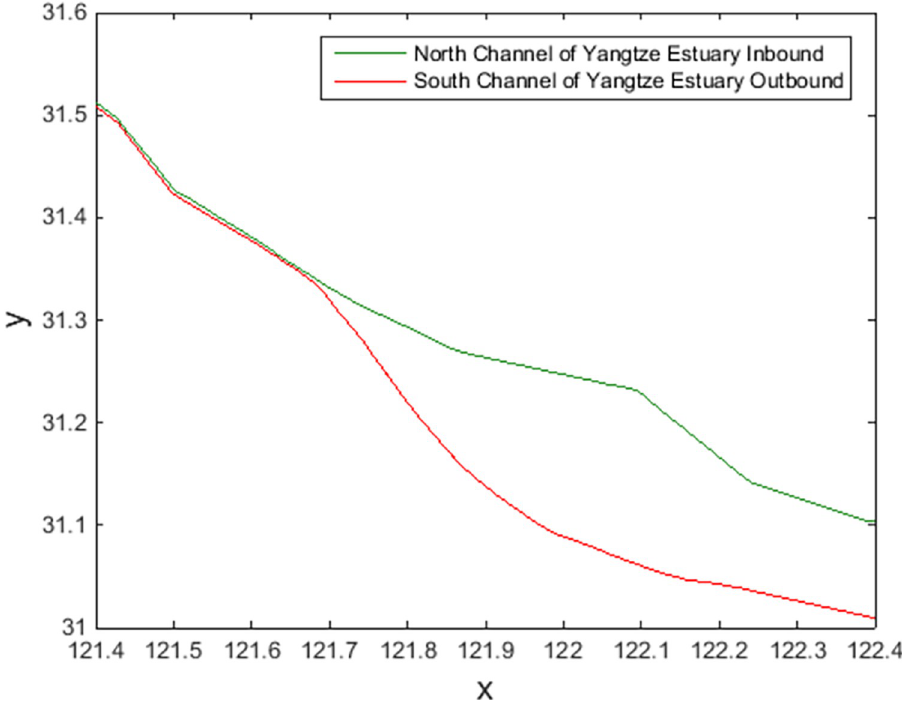
Fig 6. AIS track of ships entering and leaving